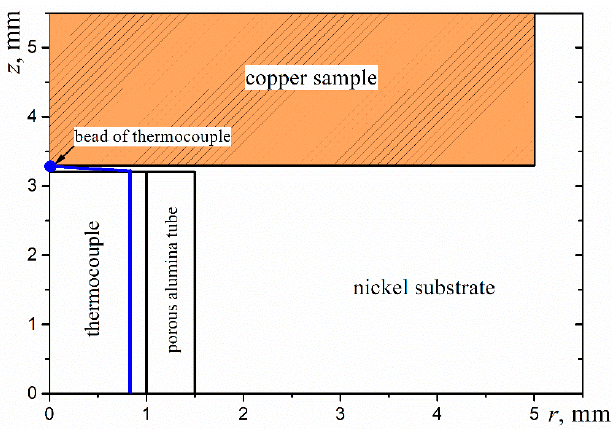
Figure 2. Schematic of the thermocouple design and